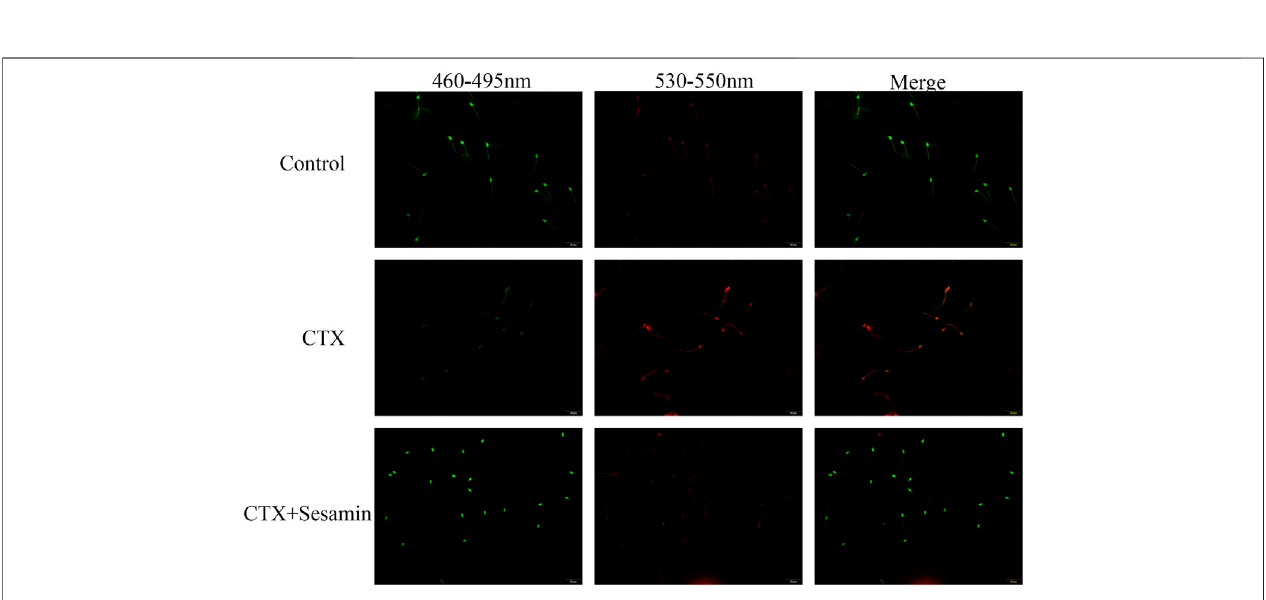
FIGURE 6 | Typical results of acridine orange on sperm smears. The green signal indicates spermatozoa which contain double-stranded DNA, while orange and red signals imply spermatozoa with single-stranded DNA or RNA.